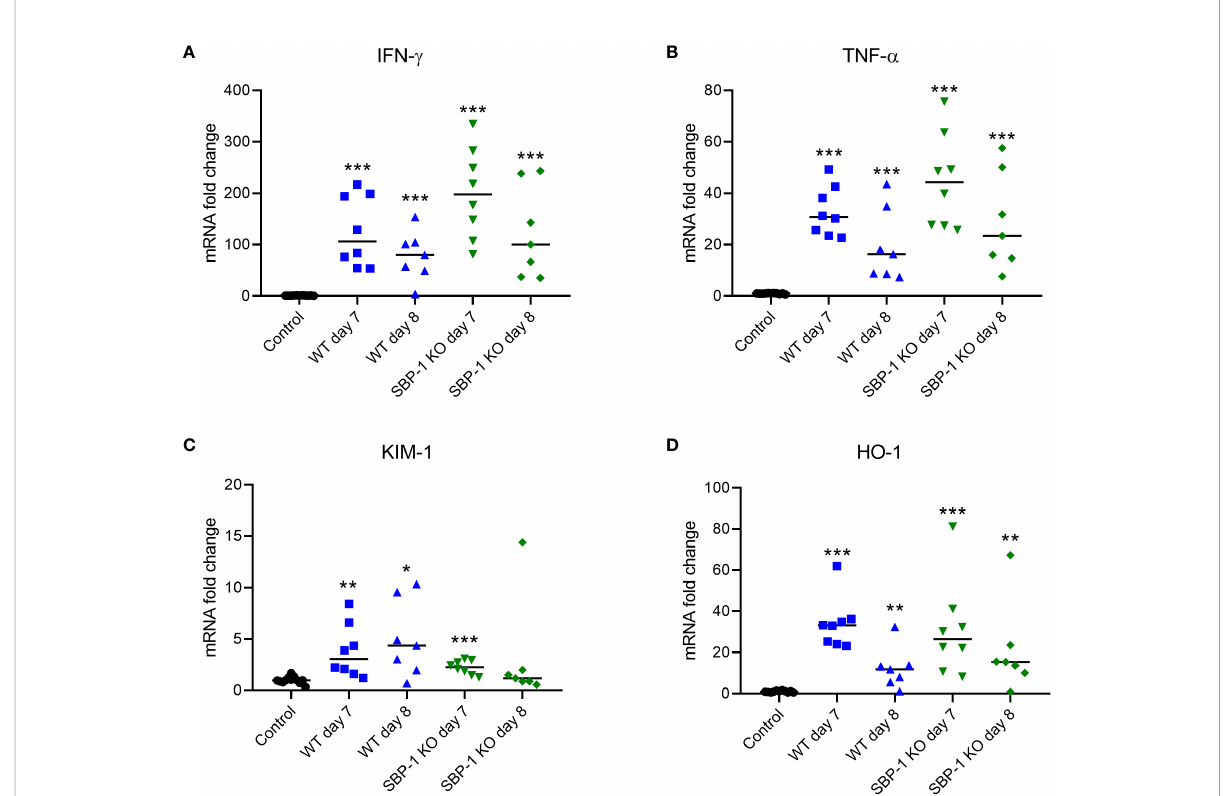
FIGURE 5 Increased expression of in fl ammatory cytokines, kidney injury molecule-1 and heme oxygenase 1 in kidneys of WT and SBP-1 KO infected mice. C57BL/6 mice were infected with WT and SBP-1 KO Pb NK65 parasites and at day 7 and 8 p.i. kidneys were dissected. Kidneys mRNA levels of (A) IFN- g , (B) TNF- a , (C) KIM-1 and (D) HO-1 were measured by qRT-PCR. Asterisks above data points indicate signi fi cant differences compared to control mice, asterisks above a horizontal line show signi fi cant differences between infected groups ,*p < 0.05, **p < 0.01, ***p < 0.001.